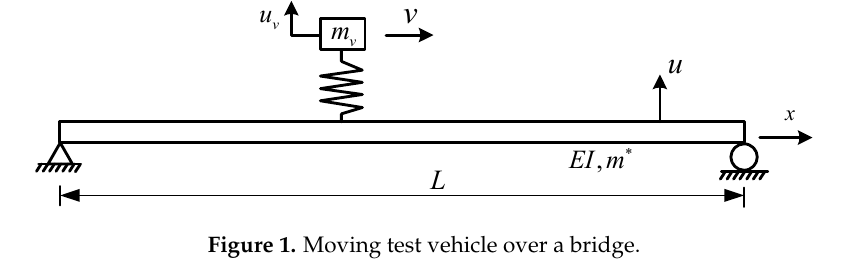
Figure 1. Moving test vehicle over a bridge.